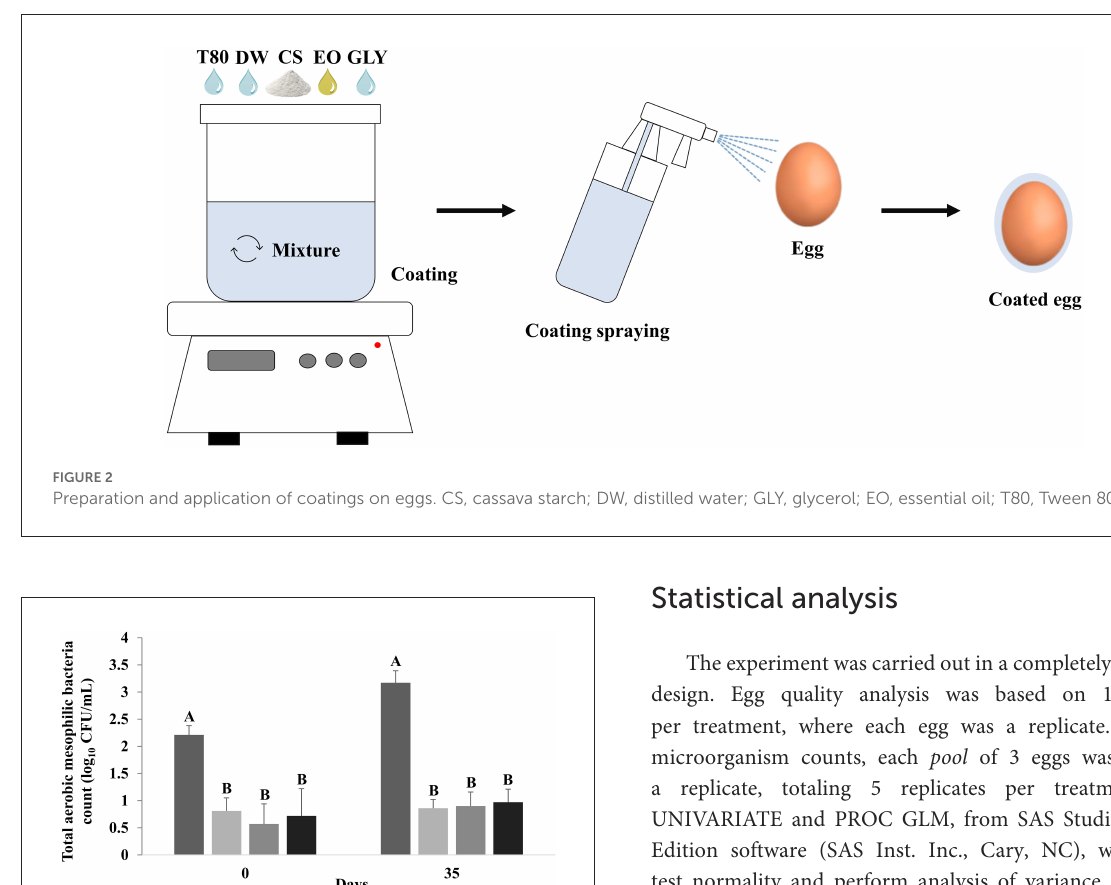
FIGURE3 Counts of total aerobic mesophilic bacteria on eggshell surfaces of the different treatments at 0 and 35 days of storage at 20 ◦ C. A − B Means with different uppercase letters differ significantly ( P < 0.05). CS + GIN, cassava starch + Ginger essential oil; CS +